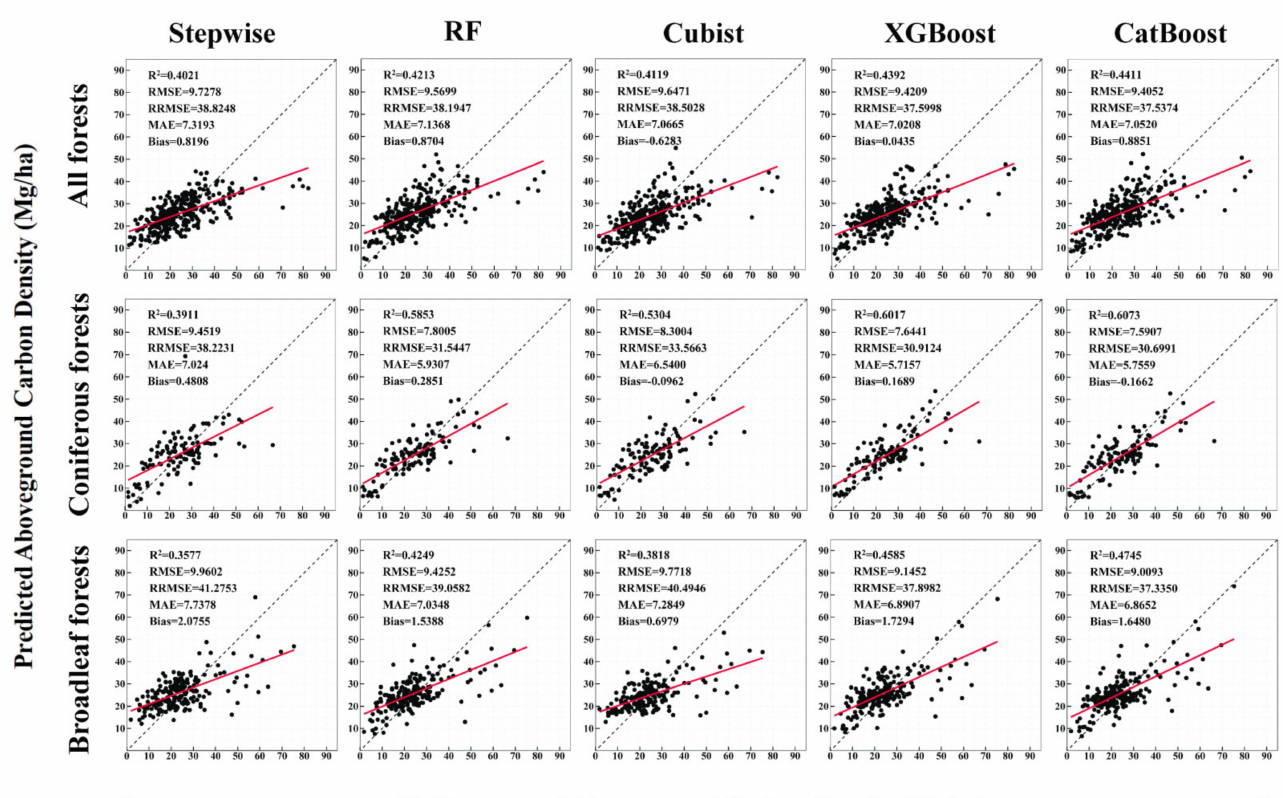
Figure 4. Scatter plots of the field-measured ( x -axis) and predicted forest AGC ( y -axis) using stepwise regression and four different ML models based on FTS in the validation